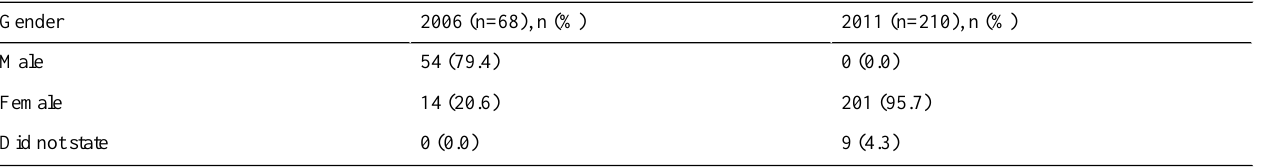
Table 2. Inquirer